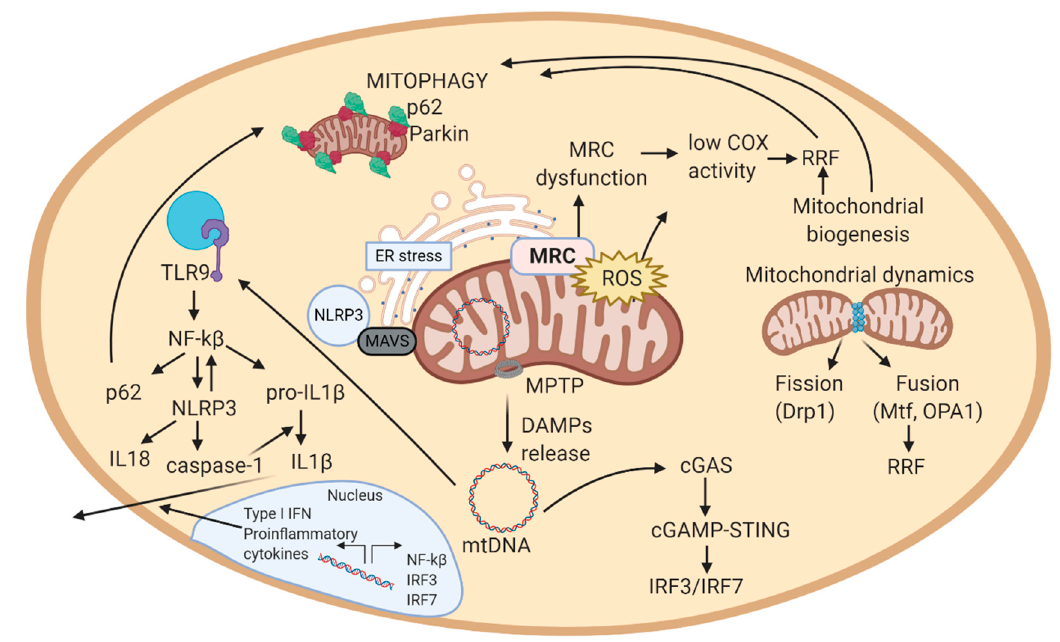
Figure 2. Schematic view of the mechanistic model of mitochondrial-related pathways in a cell. 1. MRC generates ATP in the inner mitochondrial membrane. In this process, also ROS are produced. 2. In case of excessive ROS levels, mitochondrial membrane potential decreases, allowing MPTP to open and release DAMPs (mtDNA, cardiolipin, ceramides) to the cytosol. These DAMPs can trigger an inflammatory response. In this scheme, the inflammatory cascade represented is the one activated by mtDNA. mtDNA activates cGAS in cytosol, that eventually induces the expression of interferon-related genes (IRF3 / IRF7). In parallel, mtDNA activates TLR9, which activates NF-kB, and thus, NLRP3 inflammasome, expression of pro-inflammatory cytokines, and among them, IL-1 response. 3. Increased ROS levels can result from MRC dysfunction. To compensate dysfunctional mitochondria, mitochondrial biogenesis increases the number of mitochondria in a cell. Excessive mitochondria around muscle cells form RRF. 4. Excessive ROS, RRF, inflammation, and ER stress damage mitochondria, which alterations are sensed by autophagy and mitophagy. Autophagy and mitophagy remove damaged mitochondria, and consequently stop the inflammatory response, supporting repair mechanisms in the cell. If autophagy and mitophagy are altered, mitochondria cannot be recycled, leading to apoptosis. Abbreviations: MRC: mitochondrial respiratory chain; ROS: reactive oxygen species; MPTP: mitochondrial permeability transition pore; DAMPs: damage-associated molecular patterns; mtDNA: mitochondrial DNA; cGAS: cyclic GMP-AMP synthase; TLR9: toll-like receptor 9; mitochondrial antiviral signaling protein. Figure created with